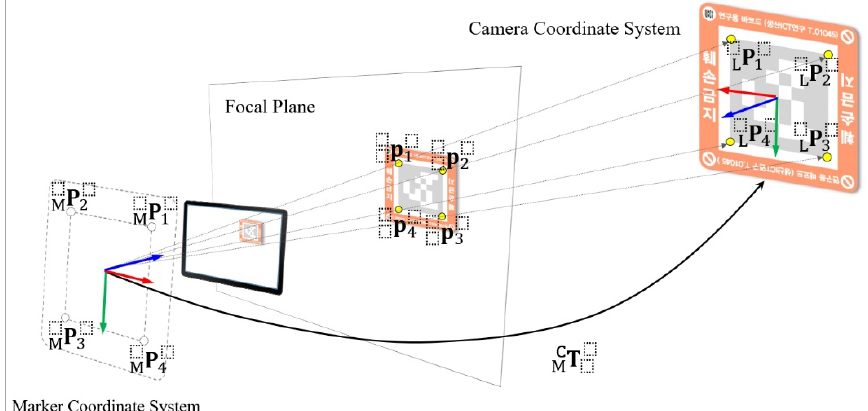
Figure 10. Scheme of marker pose recovery in camera coordinate system using camera geometry.